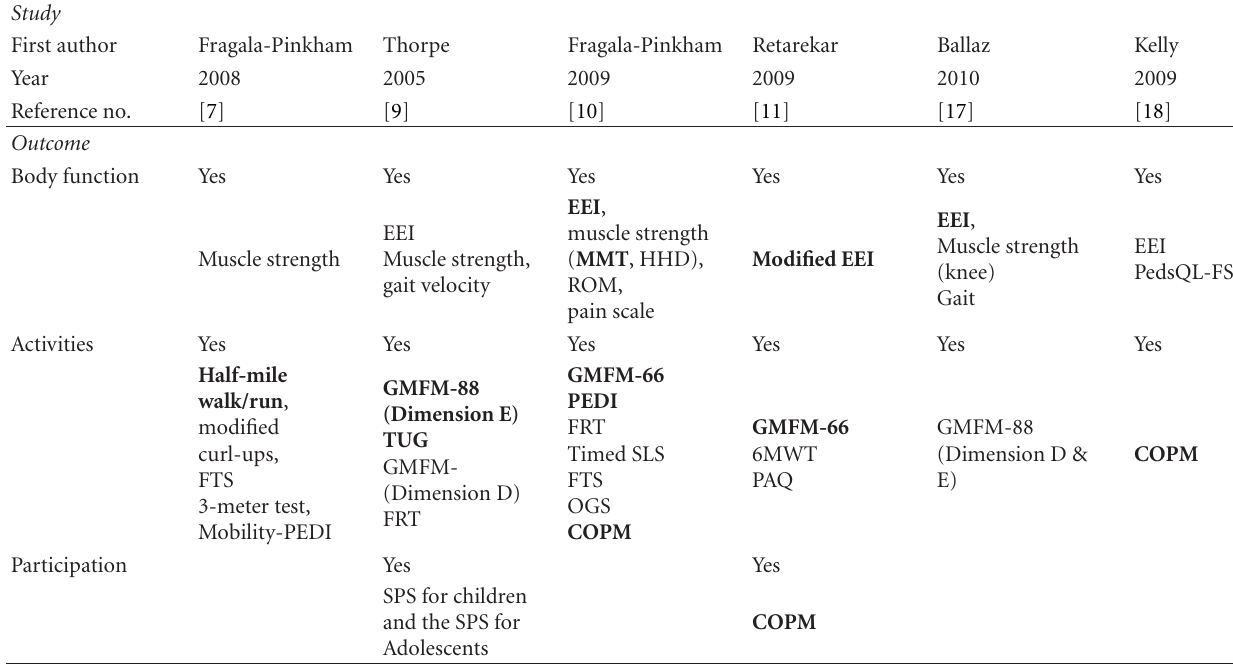
Table 3: Summary of outcomes measures used in the selected studies according to ICF-CY domain (clinically significant changes in bold).